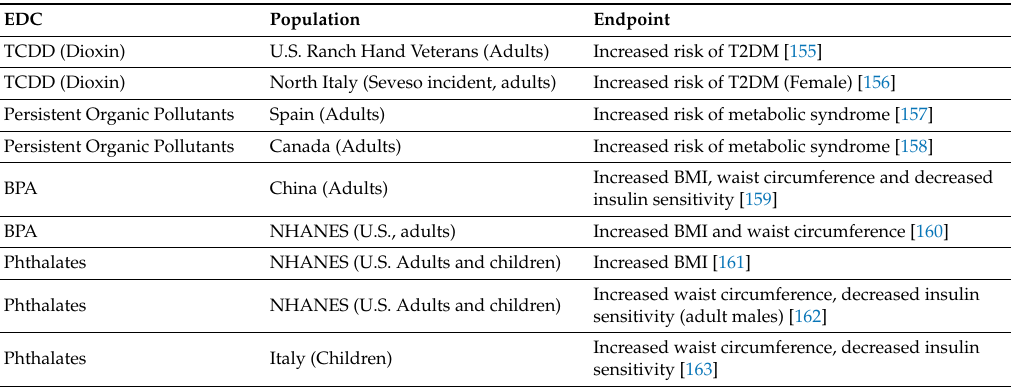
Table 2. Impact of EDCs on measures of adiposity and